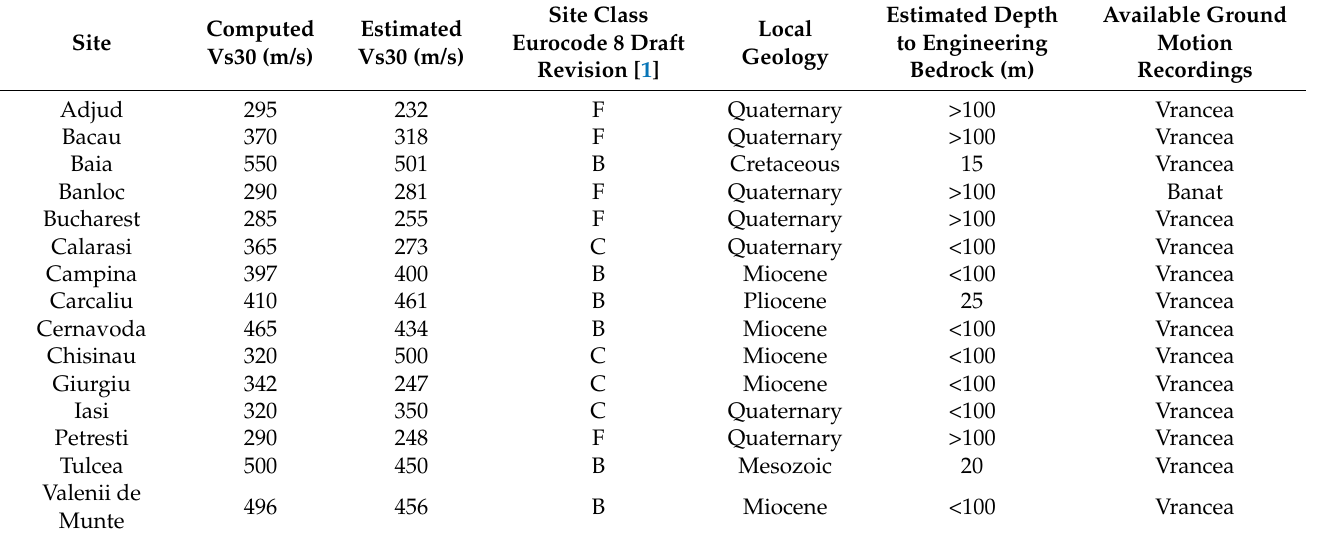
Table 1. The database of sites used in the analyses, the computed and estimated Vs30 using the topographic slope method [17], the local geological conditions, the estimated depth to engineering bedrock and the seismic source for which the ground motion recordings are